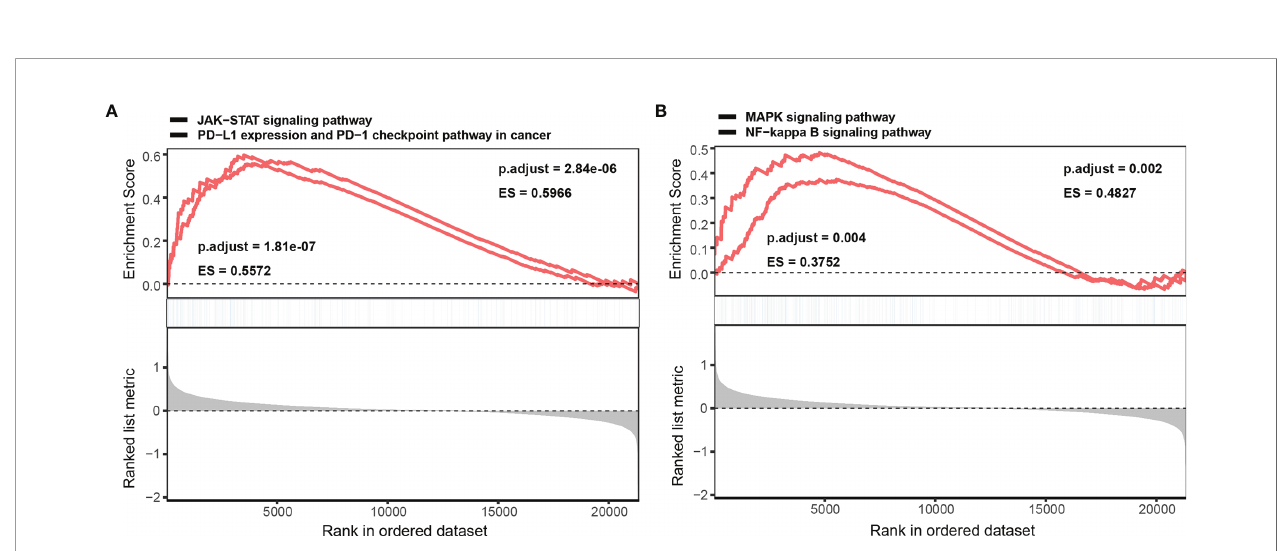
FIGURE 5 | Subgroup survival analysis of NINL by age group and stage. Subgroup survival analysis of NINL by age groups, the signi fi cant outcome results are shown independent (A – C) , subgroup survival analysis of NINL by stage groups, the signi fi cant outcome results are shown independent (D – F) .